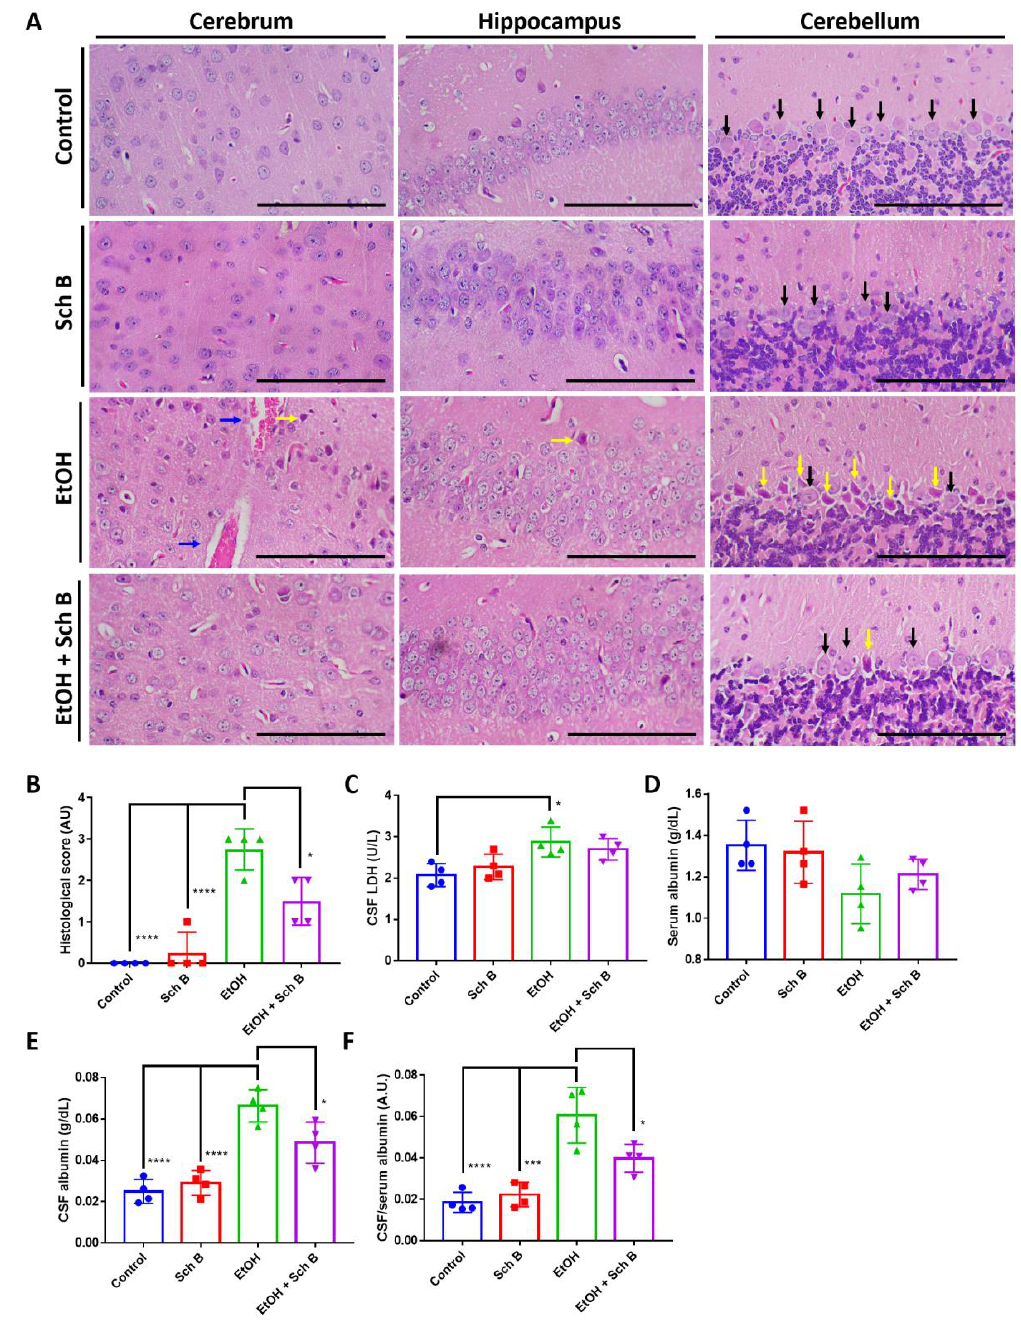
Figure 5. Schisandrin B prevents brain injuries in mice consuming ethanol. ( A ) Representative H&E-stained histological images showing the brain pathology of the mice. Congestion (blue arrows) and neuronal cell death (yellow arrows) were seen in ethanol-treated mice, which improved after Sch B treatment. Black arrows represent normal Purkinje fibers. Scale bar corresponds to 200 µ m. ( B ) Histological scores based on the histological slides from ( A ). ( C ) LDH concentration in CSF. Levels of ( D ) serum albumin, ( E ) CSF albumin, and ( F ) CSF-to-serum albumin ratio. n = 4 mice. Results are expressed as mean ± SD. * p < 0.05, *** p < 0.001, and **** p <